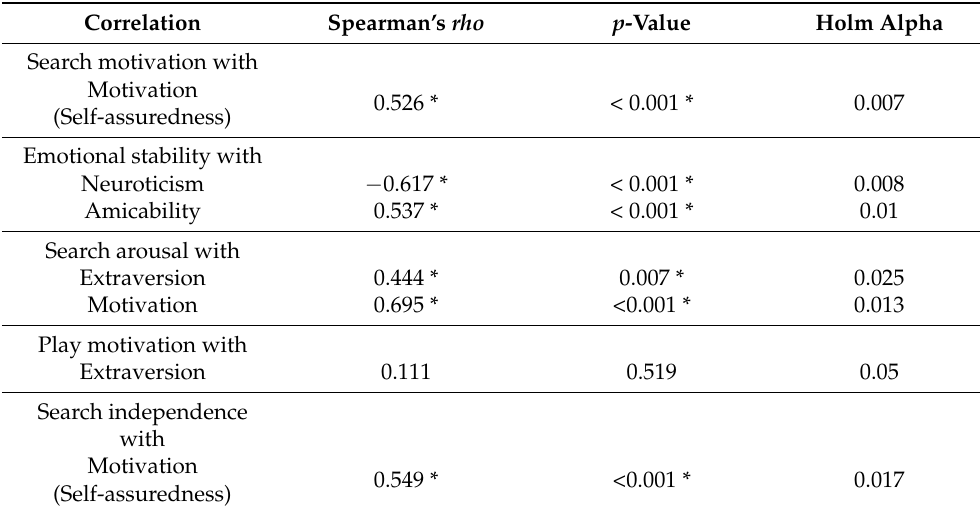
Table 5. Expected correlations between work behaviour factors and personality factors with calcu- lated correlations and significance with Holm–Bonferroni correction. The Holm alpha is the alpha needed for significance to correct for family-wise error rates.